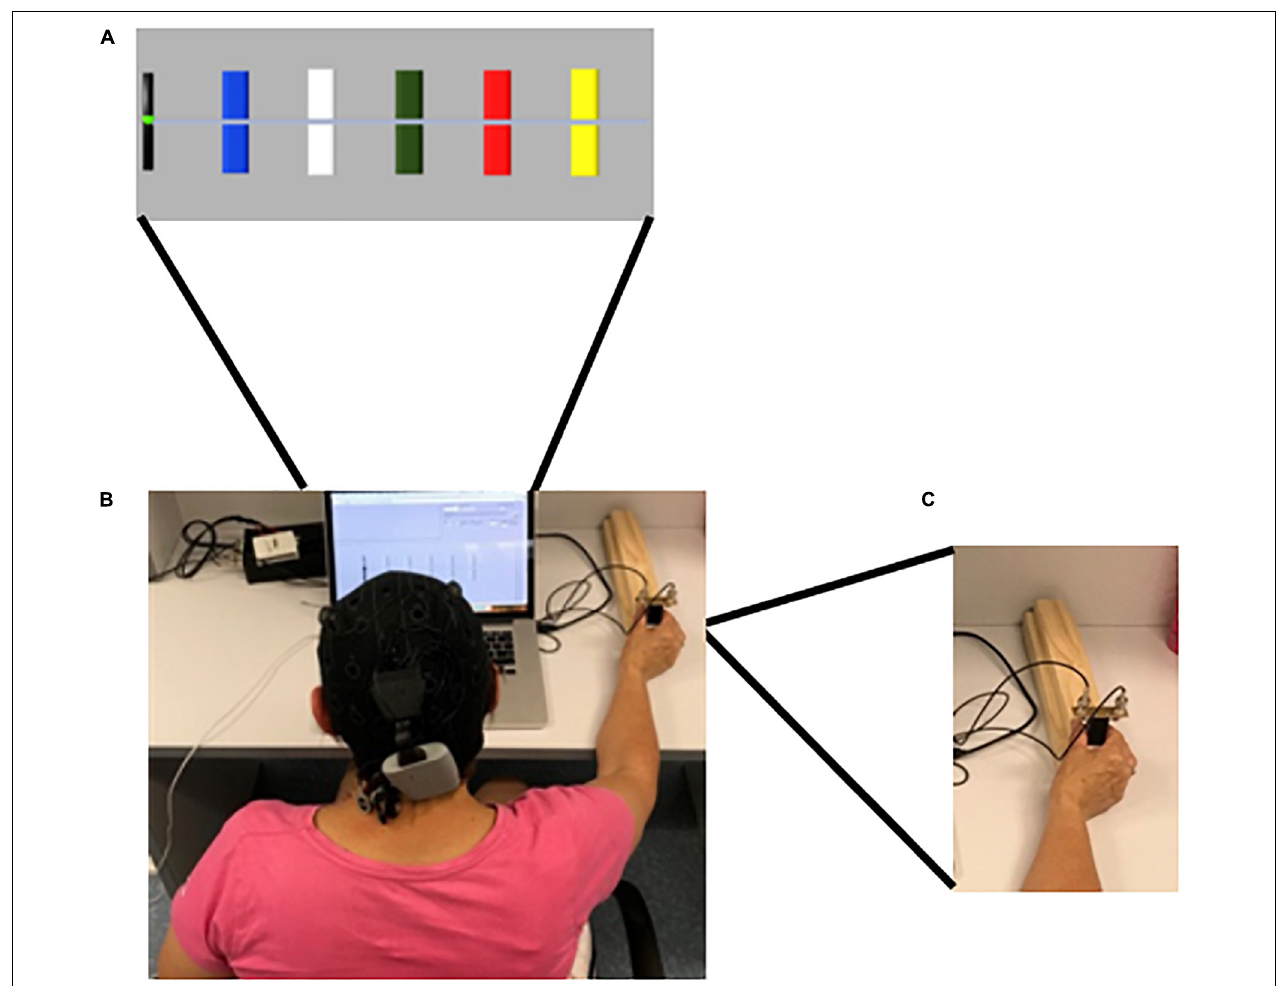
FIGURE 3 | Sequential visual isometric pinch task (SVIPT). (A) Representation of SVIPT task presented on screen to participants. The Colors were presented from left to right in the order BLUE – WHITE – GREEN – RED – YELLOW. Participants were instructed to hit the targets in the order RED – BLUE – GREEN – YELLOW – WHITE, returning to the (black) home tab between each. (B) tDCS cap with electrodes. Participants randomized into an active-tDCS group were fitted with a tDCS cap with two saline-soaked 25 cm 2 sponge-based electrodes. 20-min of 1.5 mA bi-hemispheric a-tDCS with the anodal stimulation applied over the dominant motor cortex (M1) (C3/C4), determined by participant handedness. For participants randomized to the sham-tDCS group, a 30 s ramp period was applied at the beginning and the end of the 20-min period only. (C) The cursor was moved between the home tab to each of the required colors in a horizontal motion by pinching the force transducer between the thumb and the first finger of the dominant